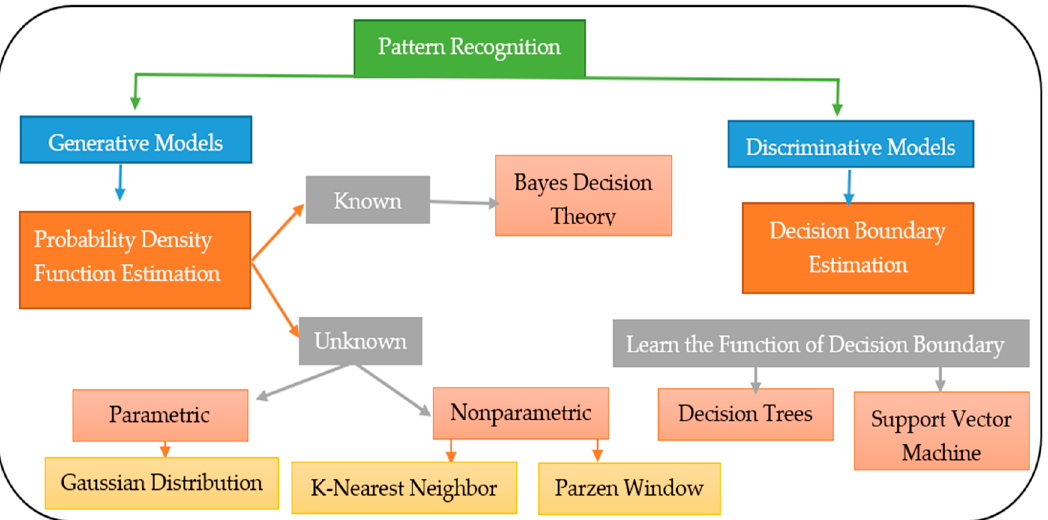
Figure 3. Pattern recognition model and algorithm structures (generative and discriminative pat- tern).